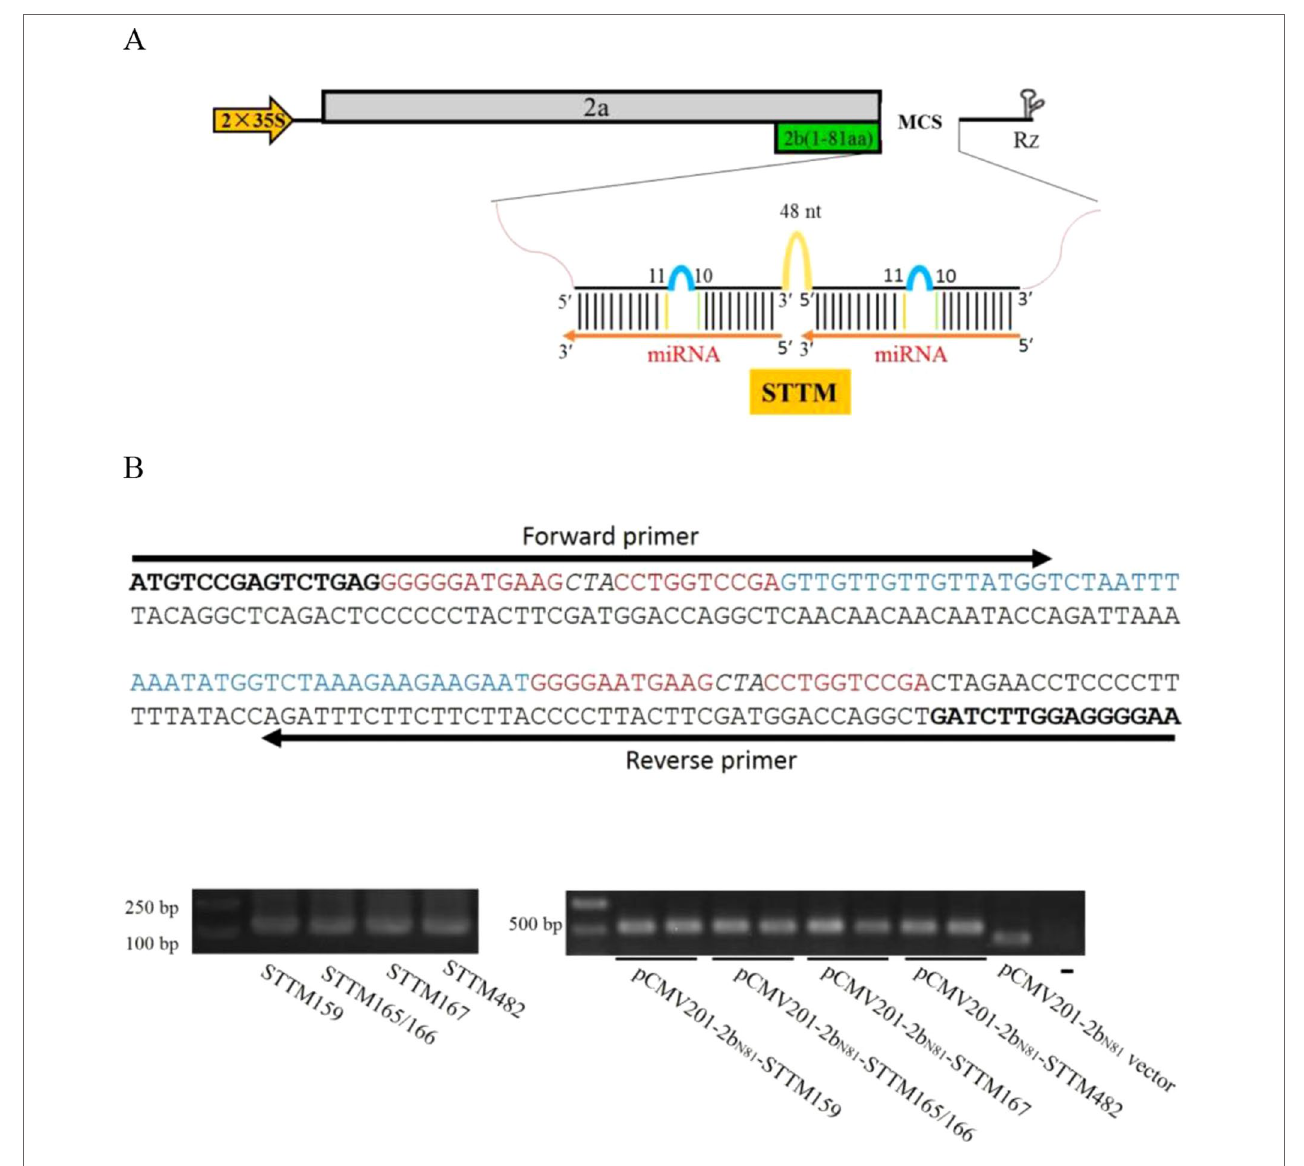
FIGURE 1 | Construction of ZMBJ-CMV201-2b N81 -STTM. (A) Schematic ZMBJ-CMV201-2b N81 vector and insertion of STTM. STTM fragments are inserted at the multiple cloning sites (MCS). (B) One-step method used to construct a STTM sequence and the recombination-based ligation method. The STTM fragments were PCR amplified with specific forward and reverse primers ( Supplementary Table S1 ). Bold, the two adapter sequences; Red, complementary strand of miR165/166; Italicized, a three nucleotide interruption linker sequence; Blue, 48 nt template; Arrows indicate the locations of the forward and reverse